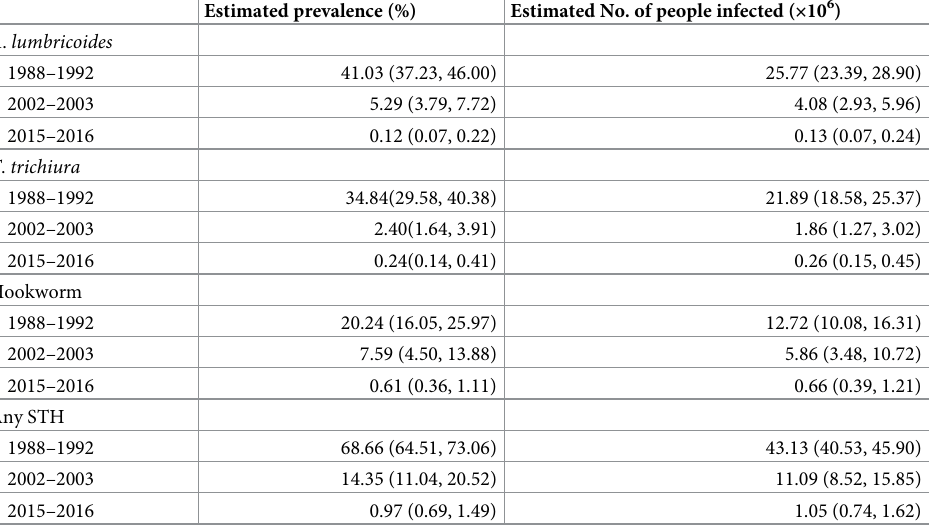
Table 4. Population-adjusted estimated prevalence (%) and number of individuals ( × 10 6 ) infected with STHs in Guangdong Province.